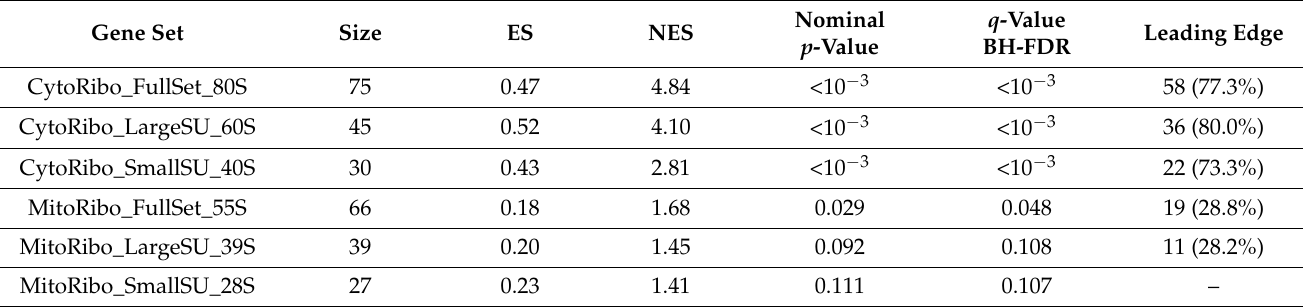
Table 4. GSEA statistics resulting from the analysis of the RPGS. Classic enrichment statistics and a preranked gene list based on a preliminary paired t-test were used (ES = enrichment score; NES = normalized enrichment score; – = empty leading edge